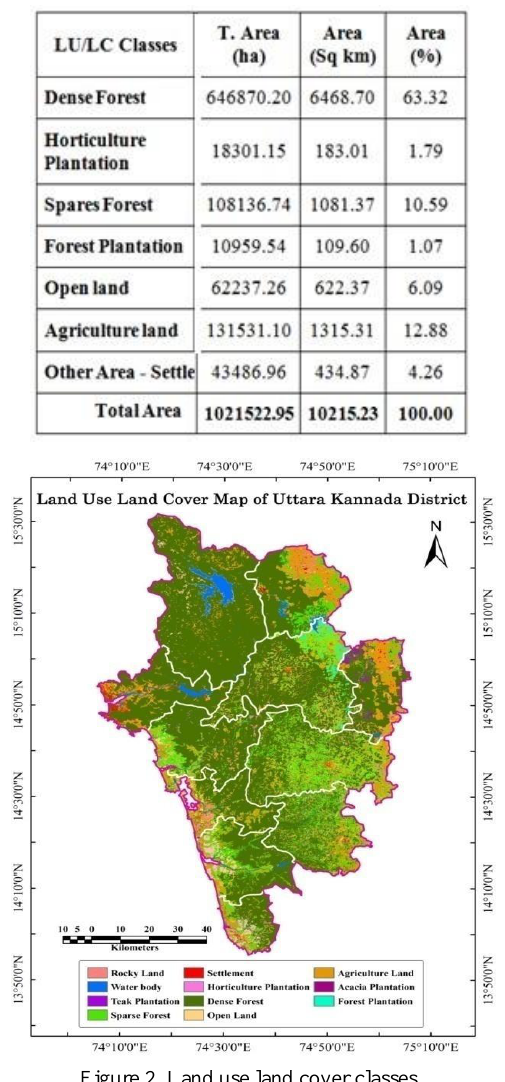
Table 1. Area covered by different LULC classes